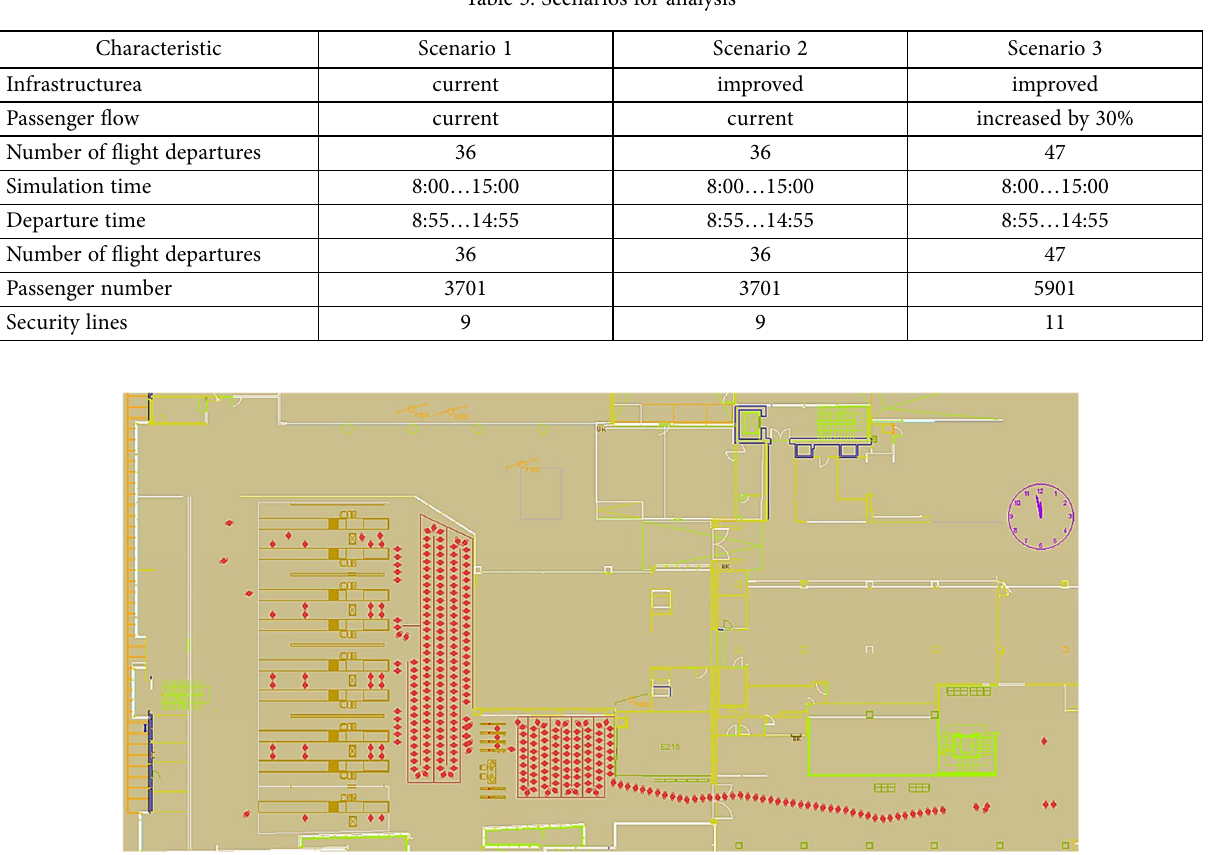
Figure 11. Visualisation of results for Scenario 1